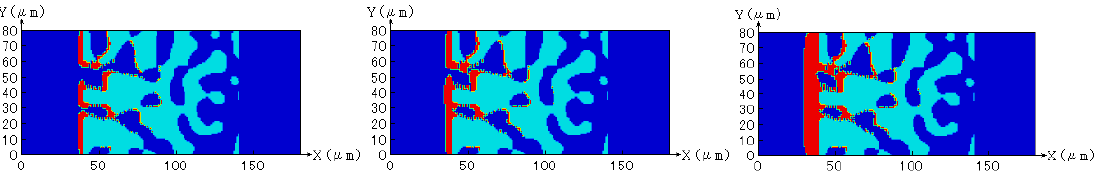
Figure 9. Slice image of soot layer in x-y plane at t = 15 s ( left ), 20 s ( middle ), 35 s ( right ) in case of Filter 1.